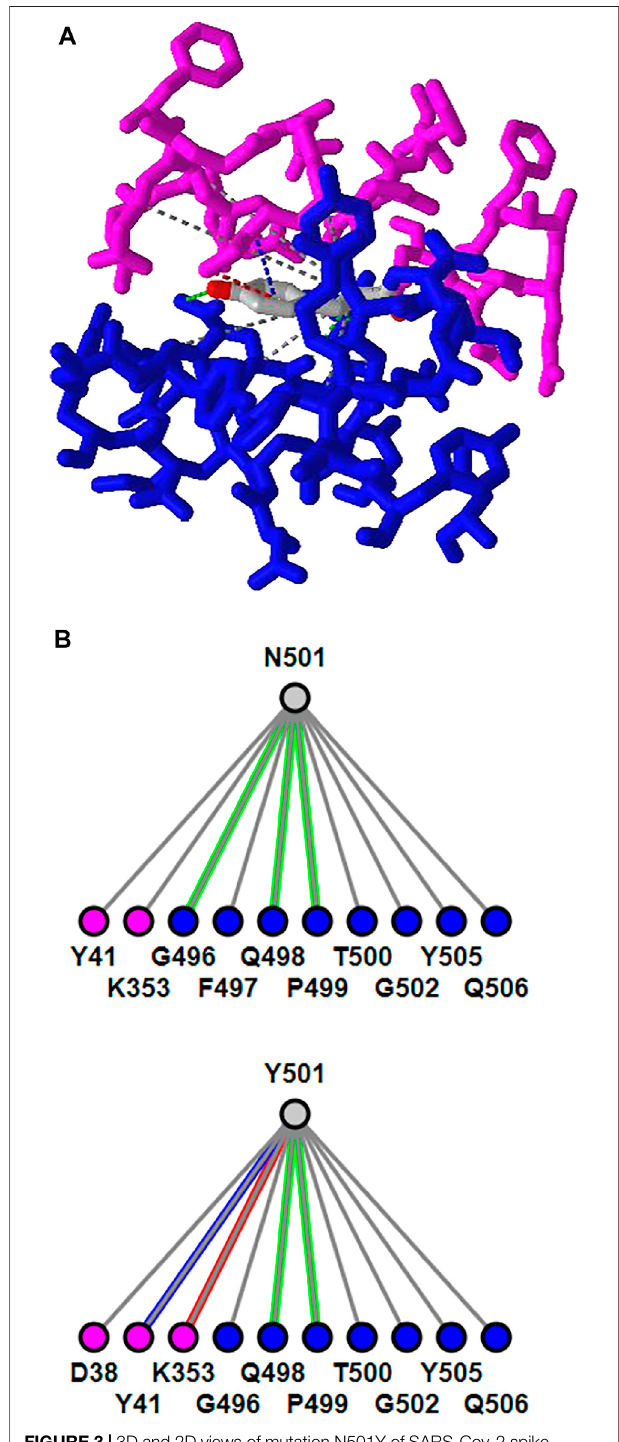
FIGURE 3 | 3D and 2D views of mutation N501Y of SARS-Cov-2 spike protein (PDB 6M0J). (A) 3D view of the mutant with Asn at position 501 mutated to Tyr. The spike protein is colored in blue and ACE2 is colored in pink. Hydrogen bonds, contacts, π -cation interaction, and π -stacking are depicted as dotted lines and are colored in green, gray, red, blue, respectively. (B) Changeofinteractionsdue tomutation. Thetoppanel shows the wild type, and the bottom panel shows the mutant. Sharable Link: https:// structure.ncbi.nlm.nih.gov/icn3d/share.html?j5Y5CkMQPU2R6smf9.